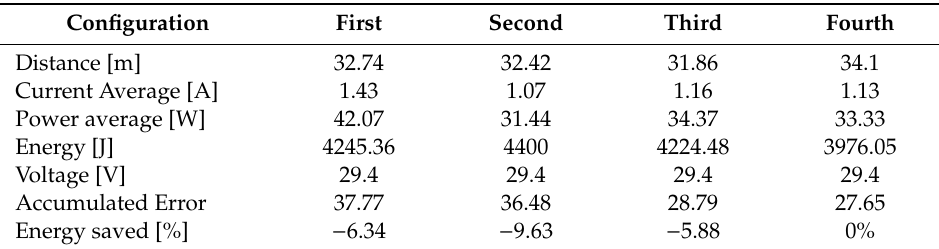
Figure 23. Power consumption in each of the tests vs. controller considering ROC analysis (red). ( a ) proposed controller 1, ( b ) proposed controller 2, ( c ) proposed controller 3. Table 2. Results of the third experiment.